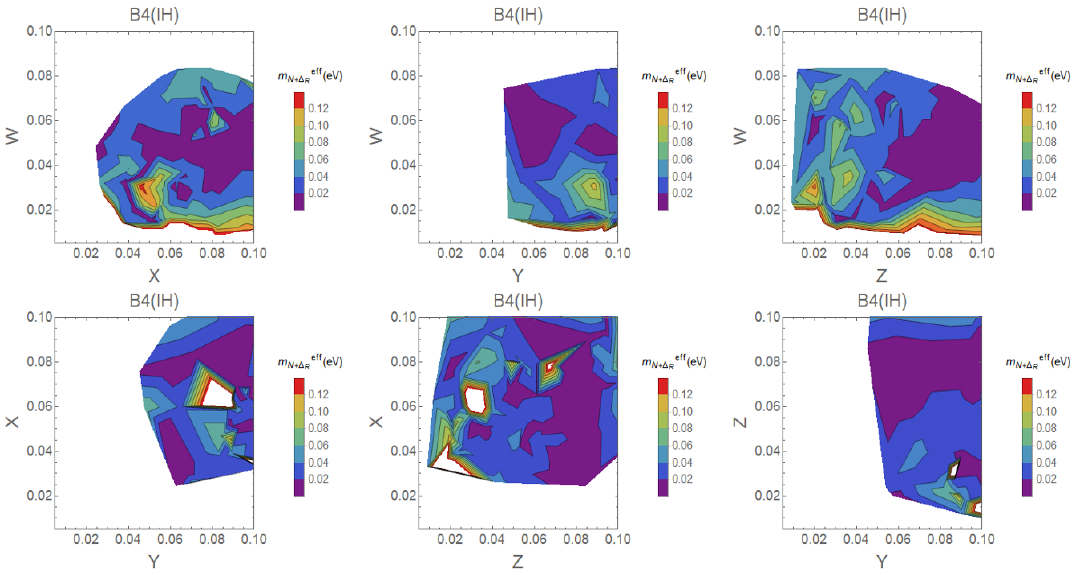
JHEP02(2019)129